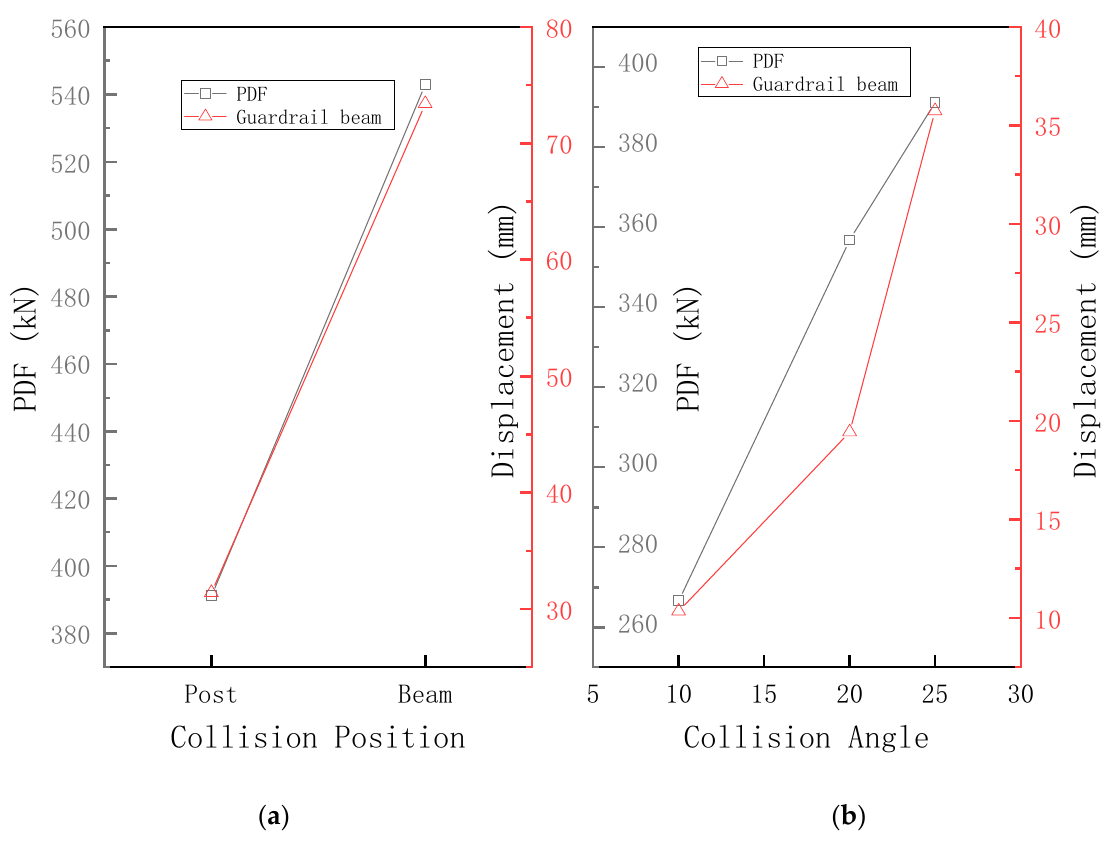
Figure 22. Effects of ( a ) collision point and ( b ) collision angle on PDF and maximum displacement of the guardrail beam.